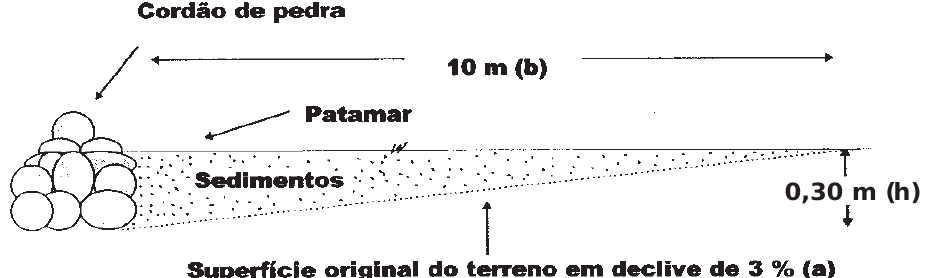
Figura 1. Esquema da deposição do solo desagregado, transportado e retido sob forma de sedimentos pelo cordão de pedra em contorno (b), com a suavização do declive (a), formando um patamar natural